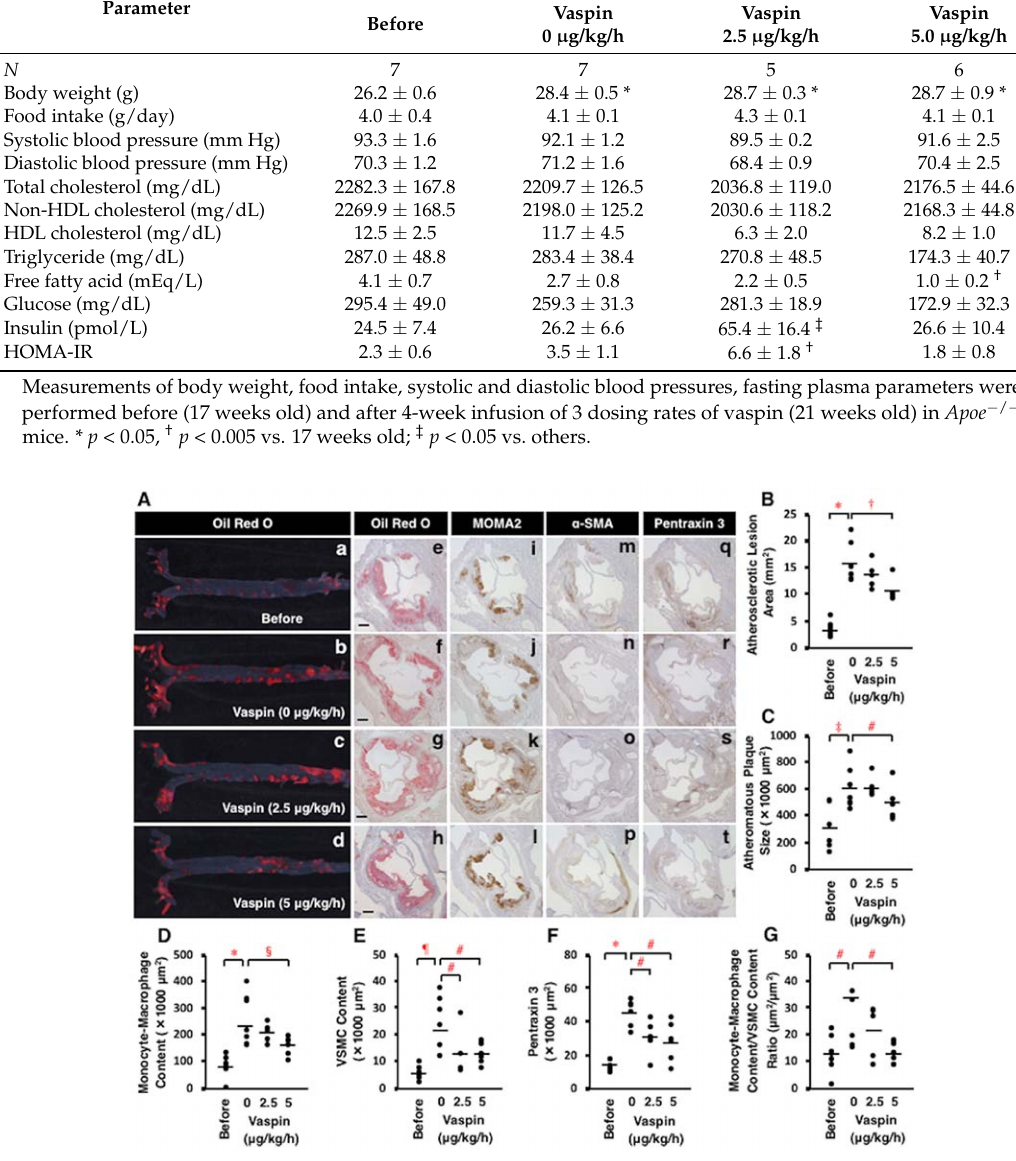
Figure 6. Effects of vaspin on atherosclerotic lesion development in Apoe − / − mice. Seven mice were sacrificed before infusion (17 weeks old), and 7, 5, and 6 mice were sacrificed after a 4-week continuous subcutaneous infusion of 3 dosing rates of vaspin (0, 2.5, 5 µ g/kg/h), respectively. ( A ) Atherosclerotic lesions were stained with Oil Red O on the aortic surface ( a – d ). Cross-sections of the aortic sinus were stained with Oil Red O ( e – h ), MOMA2 for monocytes/macrophages ( i – l ), α -SMA for VSMCs ( m – p ), or pentraxin 3 for vascular inflammation ( q – t ). Hematoxylin was used for nuclear staining. Bar = 200 µ m. ( B – G ) Comparisons of these positive area and the ratio of monocyte-macrophage content/VSMC content within atheromatous plaques were performed among 4 groups. Bars indicate the mean values in the graphs. * p < 0.0001, † p < 0.005, ‡ p < 0.001, # p < 0.05, § p < 0.01, ¶ p <